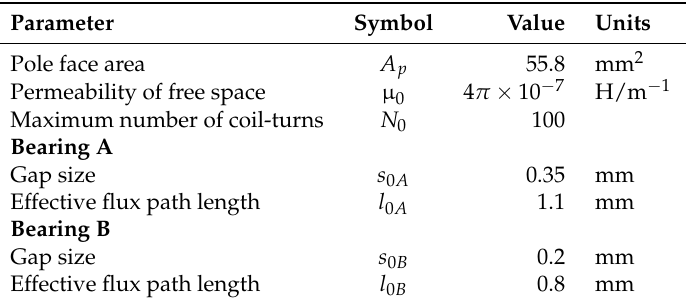
Table 3. Properties of DAMB actuators.